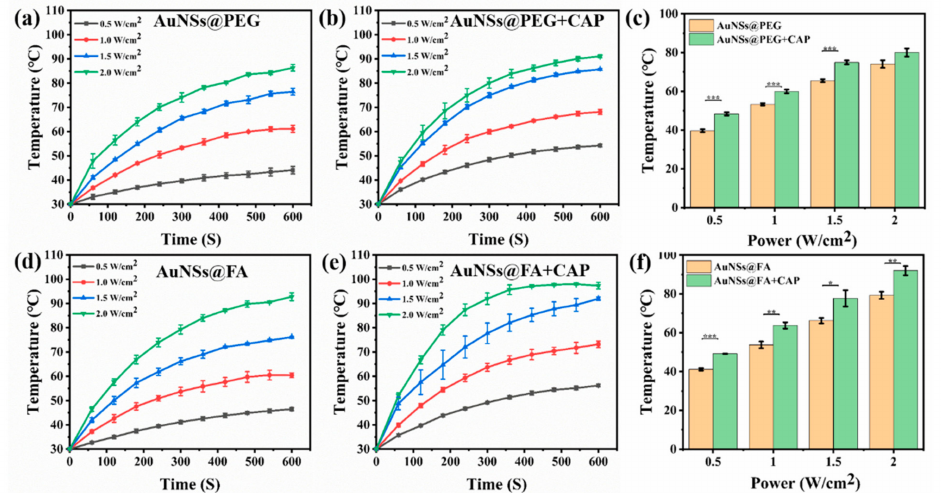
Figure 3. The heating curves of 100 mg/L ( a ) AuNSs@PEG, ( b ) AuNSs@PEG+CAP, ( d ) AuNSs@FA, and ( e ) AuNSs@FA+CAP at different laser power densities. Contrast charts of ( c ) AuNSs@PEG and ( f ) AuNSs@FA at the same Au concentration of 100 mg/L, at 300 s by different powers of 808-nanometerlaser irradiation. * p <0.05 was considered statistically significant. ** p <0.01 and *** p <0.001 were considered highly statistically